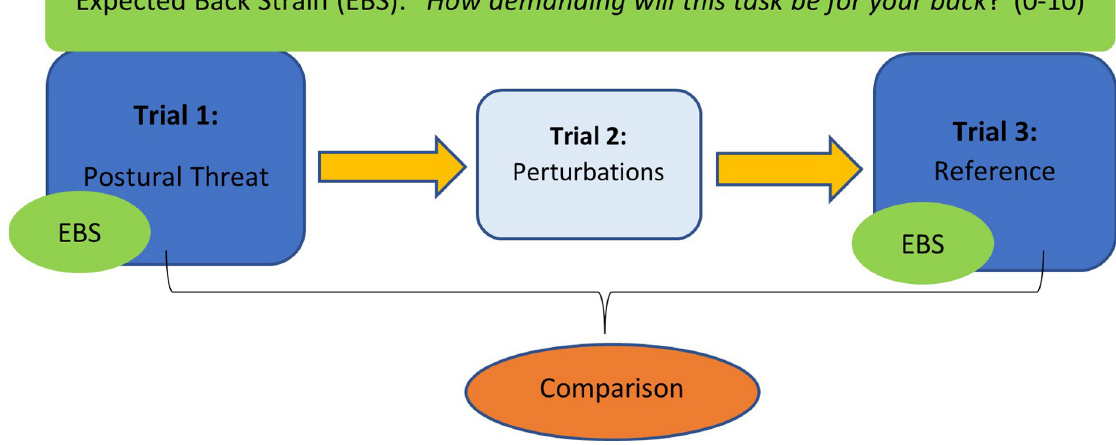
Fig 1. Experimental design. Each trial consisted of 45 repetitive seated reaching